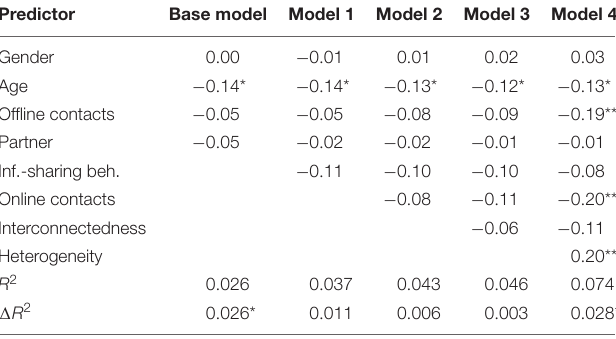
TABLE 5 | Regression results using emotional loneliness as the